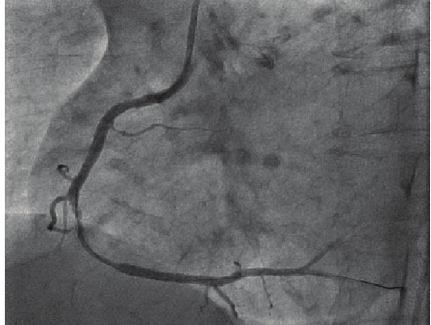
Figure 6: Right coronary artery and WCA after first distal stent implantation.